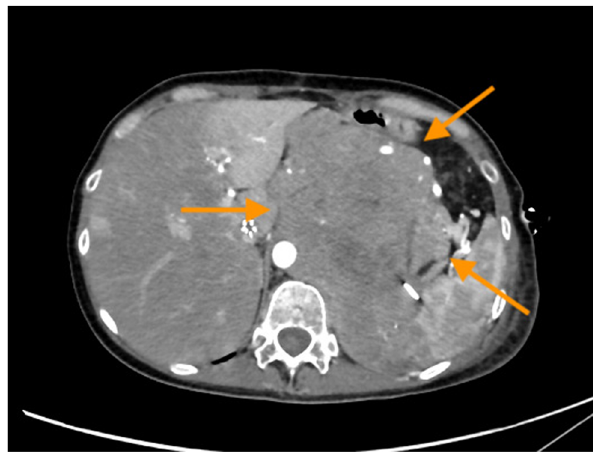
Figure 3: CT - scan, the imaging revealed a huge recurrence in the surgical site ( arrows ) with involvement of thoracic wall.